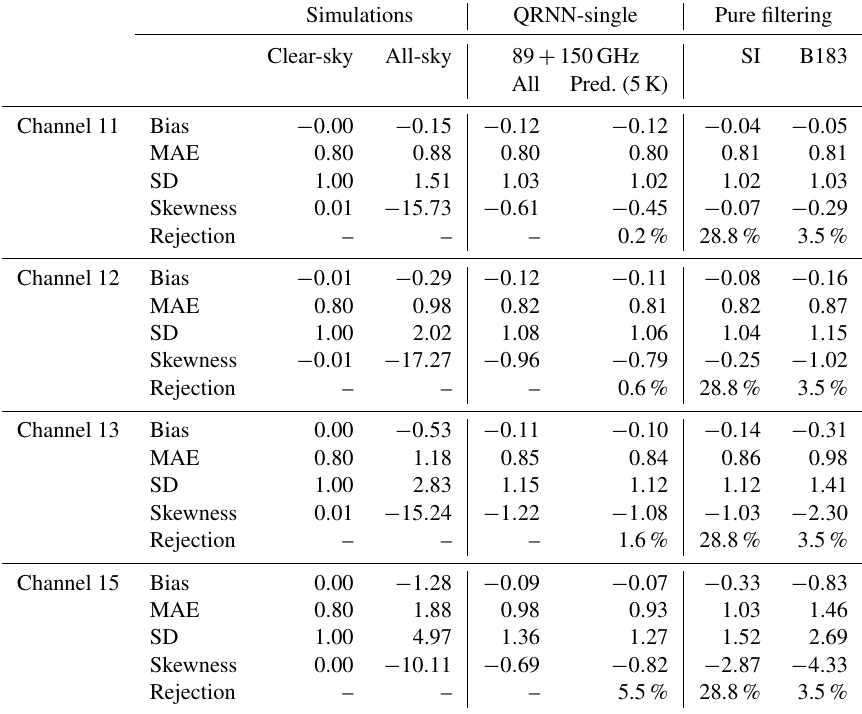
Table 5. As Table 4 but for MWHS-2 channels 11, 12, 13 and 15, and the QRNN-single 89 + 150GHz experiment. Simulations